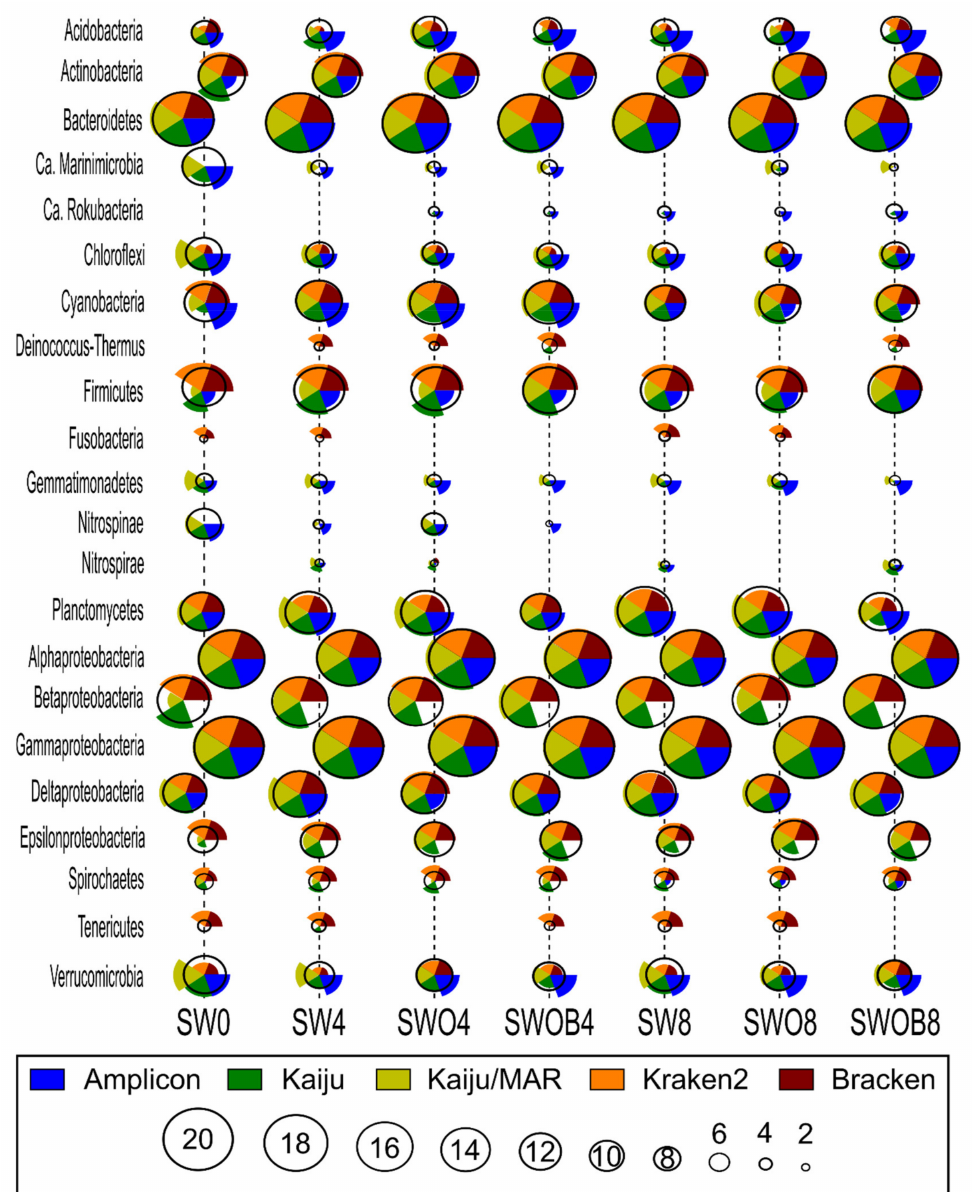
Figure 3. The comparison of bacterial community structure at the phylum level (Proteobacteria at class level) by ranks of the 20 most prominent taxa of each sample (highest rank value corresponds to highest proportion in bacterial community) by different taxonomic classification methodologies (Kaiju with NCBI-nr and MAR DB databases, Kraken2 and Bracken with Standard Kraken2 database, and amplicon-based data with SILVA database) in seawater (SW), oil-contaminated seawater (SWO), and biostimulated oil-contaminated seawater (SWOB). The numbers in sample codes denote time in months. The height of each pie chart slice corresponds to the rank estimate of the individual classification method for the taxon in question, while the calculated average rank for all classification methods is indicated by the black